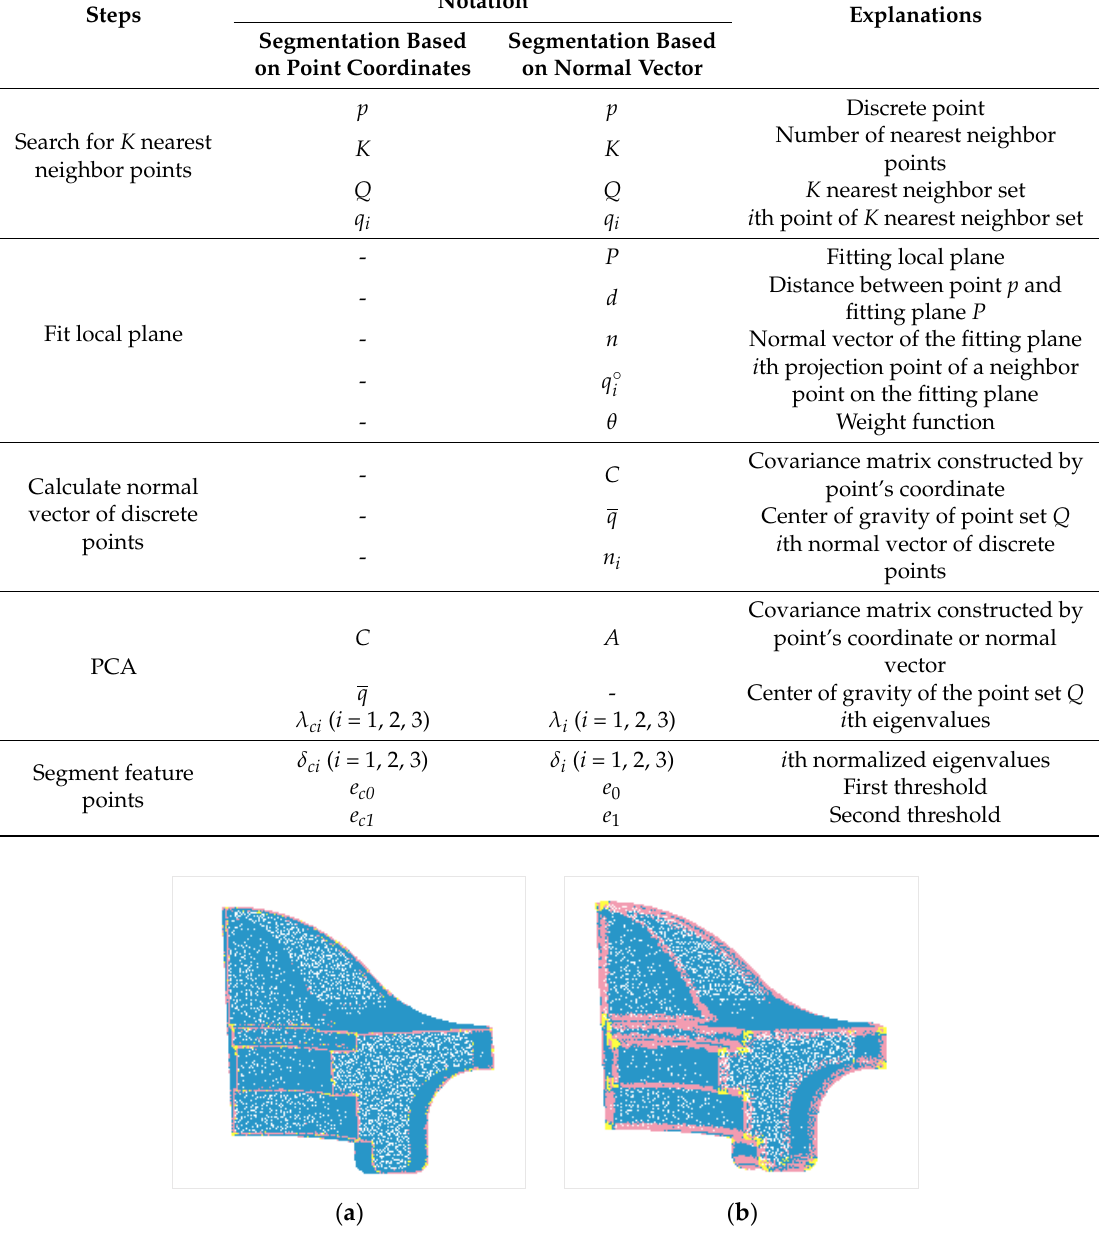
Figure 4. PCA results of point cloud segmentation by using ( a ) point coordinates and ( b ) the normal vector distribution matrix. The blue, pink, and yellow points denote the surface, edge, and corner points, respectively.